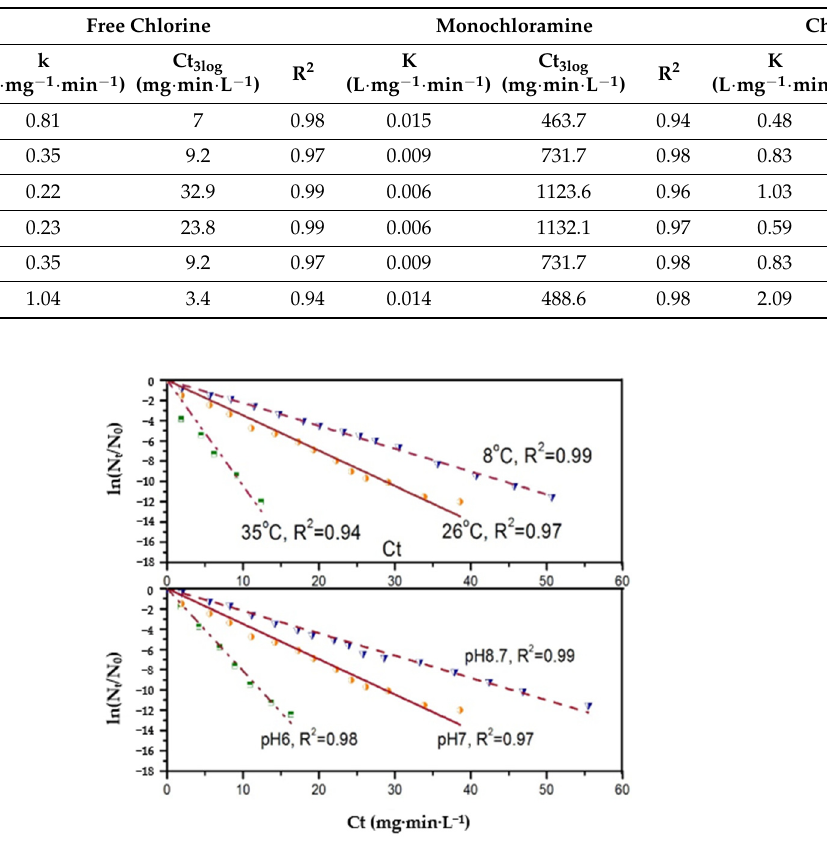
Figure 2. Inactivation on N. europaea applying free chlorine. Experiments were conducted in PBS buffers at temperature varying from 8 °C to 26 °C to 35 °C and pH varying from 6.0 to 8.7. Linear regressions based on the Chick–Watson model are represented as Equation (1) for different pH and temperature conditions. R 2 represents the correlation coefficient values.